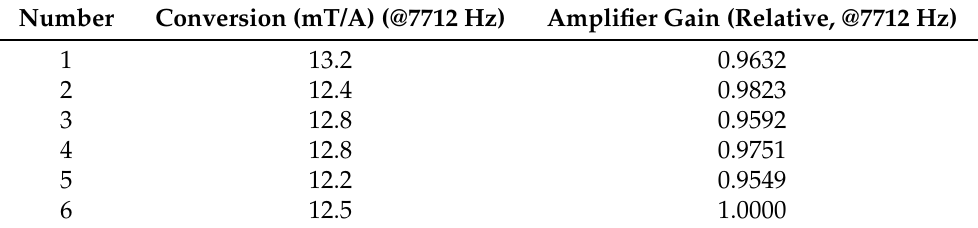
Table 1. Parameter of the coils and amplifier channels used in this study. The conversion factors of the coils describing the relationship between current and magnetic field are described by the column conversion . The gains of the coil amplifier channels are normalized to the maximum value (channel 6). Both values are determined at the resonance frequency of the sensor.